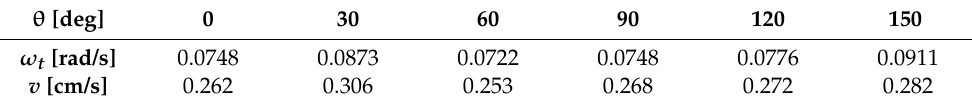
Table 8. Angular velocity and linear velocity according to the receiving coil angle.